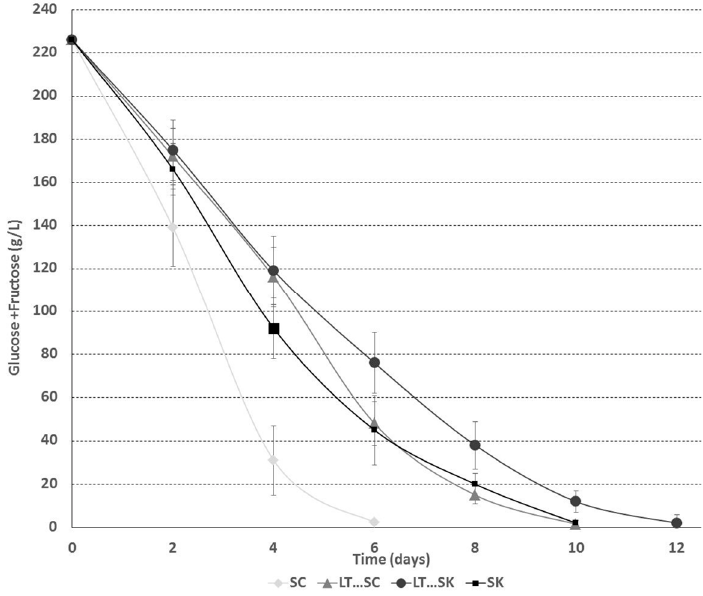
Figure 2. Fermentation kinetics of glucose + fructose for Saccharomyces cerevisiae 88 alone (SC), a sequential fermentation with Saccharomyces cerevisiae 88 and L. thermotolerans CONCERTO™ (LT…SC), a sequential fermentation with Schizosaccharomyces pombe V2 and L. thermotolerans CONCERTO™ (LT…SK) and Schizosaccharomyces pombe V2 alone (SK).